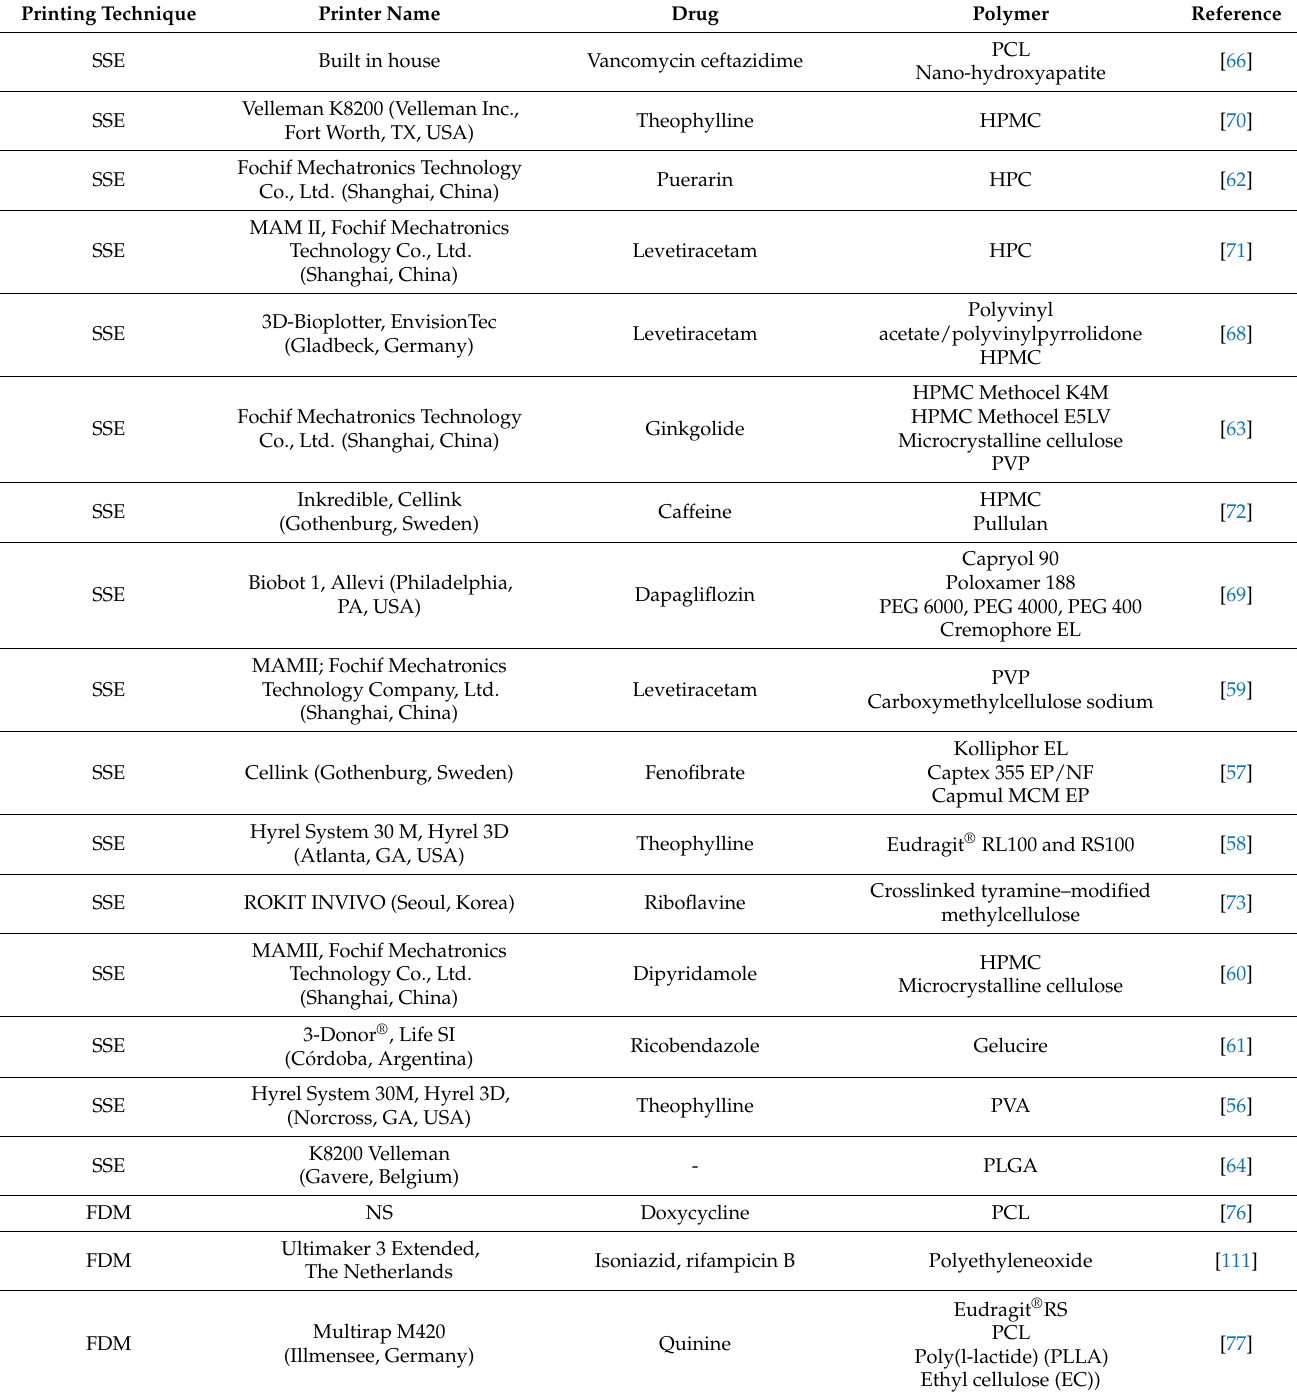
Table 1. Summary of polymers and printer types used for printing thermosensitive